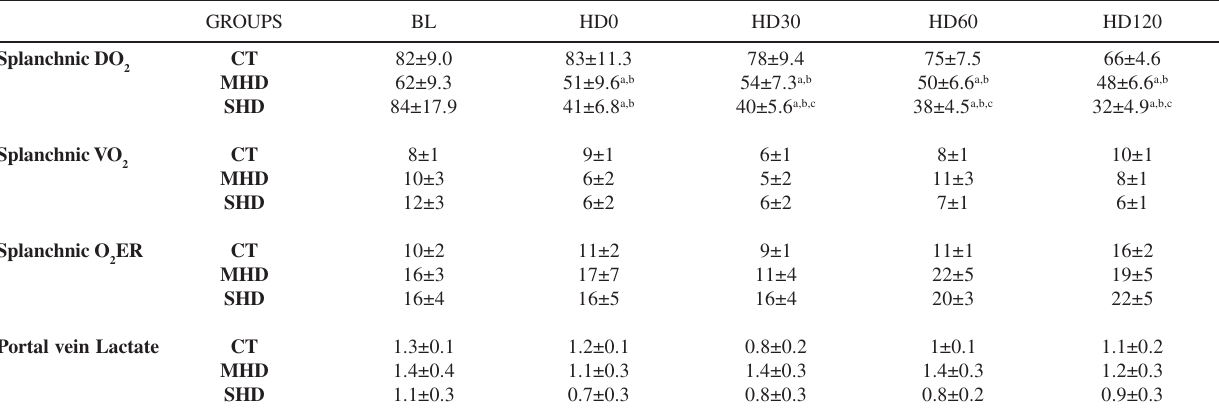
Table 2 - Splanchnic oxygen delivery, consumption and extraction (DO lactate levels, in control (CT) moderate and severe hemodilution (MHD and SHD)